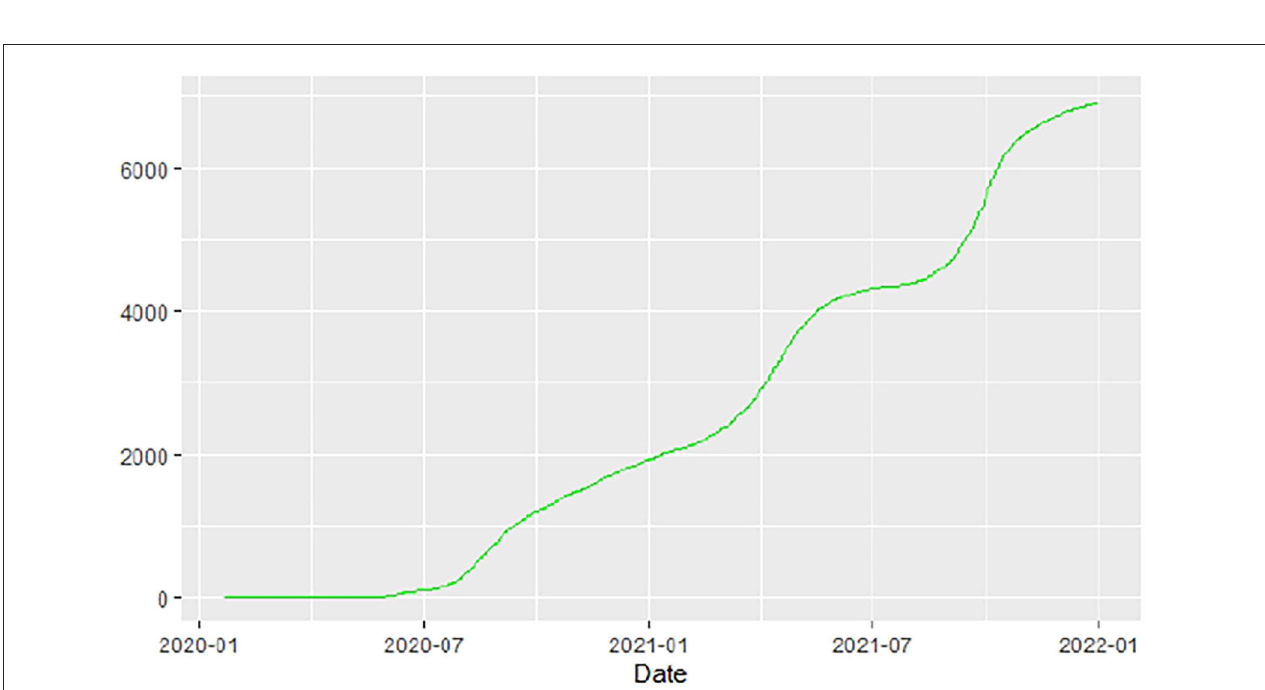
FIGURE 14 | Ethiopia